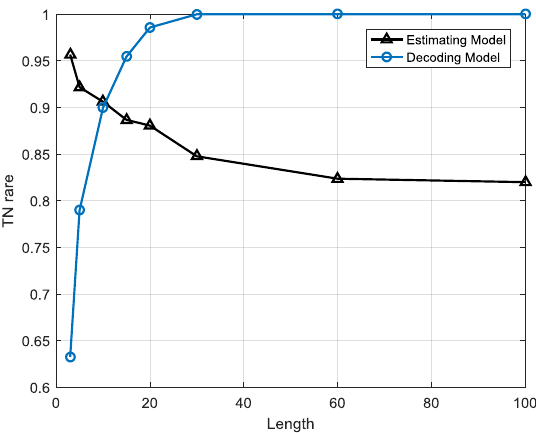
Figure 18. Comparison between the estimation-based and decoding-based models on TN rate.